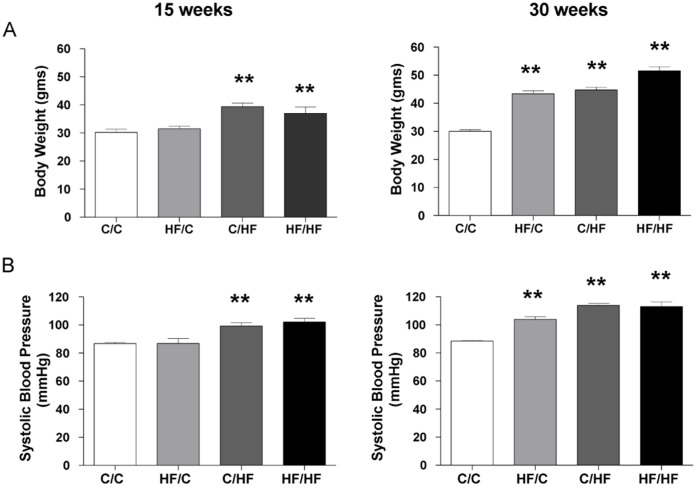
Phenotype of male mouse offspring at 15 and 30 weeks of age.Dams were assigned to either a high fat (HF) diet or standard chow (C) for 4 weeks before conception and during gestation and lactation. At weaning, offspring were assigned to C or HF to give four dietary groups C/C, HF/C, C/HF and HF/HF. Bar graphs represent mean ± SEM for (A) Body weight from 15 week C/C n = 9, HF/C n = 8, C/HF n = 7, HF/HF n = 9 and 30 week C/C n = 10, HF/C n = 10, C/HF n = 10, HF/HF n = 10 offspring, and (B) Systolic blood pressure measured by tail-cuff plethysmography from 15 week and 30 week offspring (C/C n = 7, HF/C n = 7, C/HF n = 5, HF/HF n = 9). Statistical comparisons were by ANOVA for the effects of maternal and offspring diet and age (see Table 2) followed by analysis using post hoc Dunnett’s multiple comparison tests for HF/C, C/HF and HF/HF vs. C/C. Values significantly different between high fat fed offspring groups and control offspring (C/C) at 15 or 30 weeks of age are indicated by ** p<0.001.